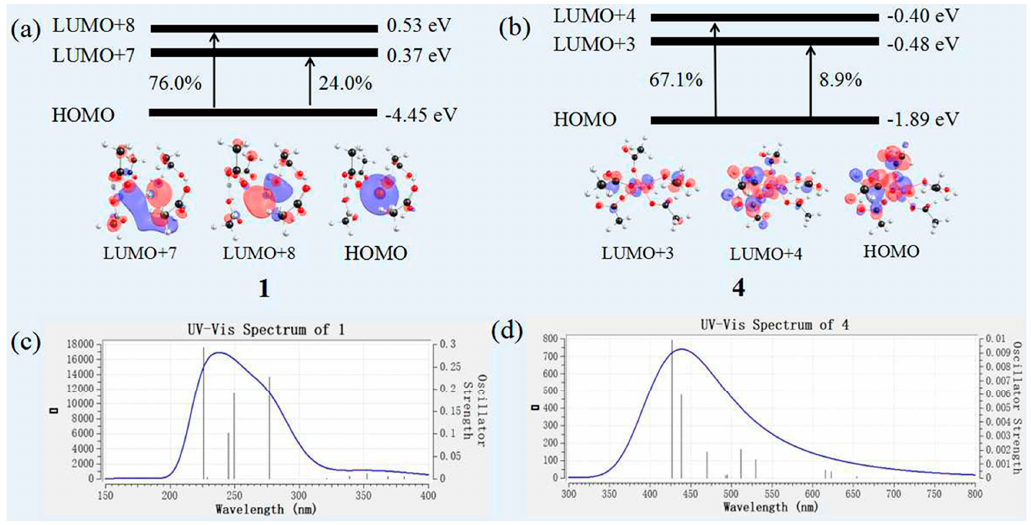
Figure 5. The calculated excitation of complexes 1 ( a ) and 4 ( b ) and the calculated emission spectrum of 1 ( c ) and 4 ( d ) at the theoretical level of TD − M06L/6 − 31G(d,p), where the SDD e ff ective core potential was applied for the metallic elements.